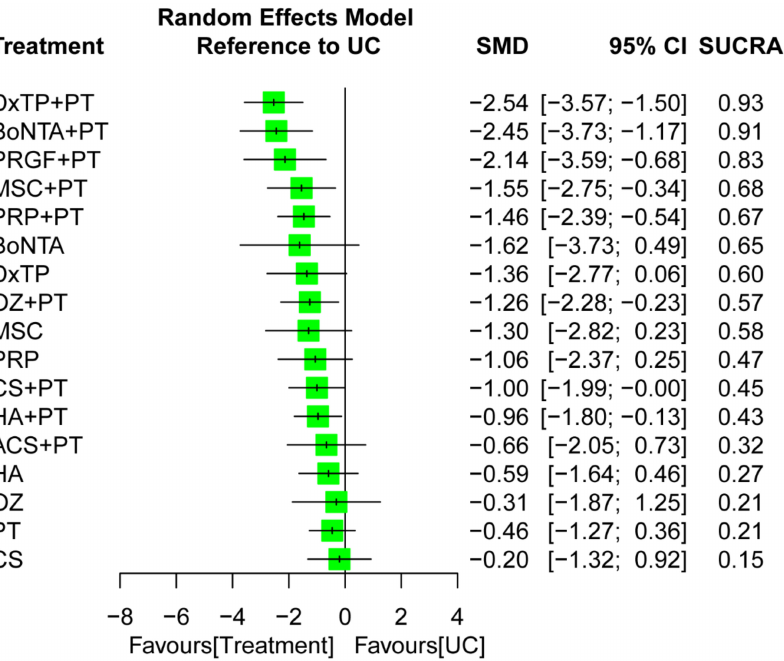
Figure 2. Network plot of direct comparisons among treatments for ( A ) pain, ( B ) global function, and ( C ) walking capability. The lines between nodes indicate direct comparisons in other studies. The size of each node is proportional to the number of participants. The thickness of each line is proportional to the number of studies denoted on the line. ACS, autologous conditioned serum; BoNTA, botulinum toxin type A; CS, corticosteroid; DxTP, dextrose prolotherapy; HA, hyaluronic acid; MSC, mesenchymal stem cell; OZ, ozone; PRP, platelet-rich plasma; PRGF, plasma rich in growth factor; PT, physical therapy; SVF, stromal vascular fraction; UC, usual care.